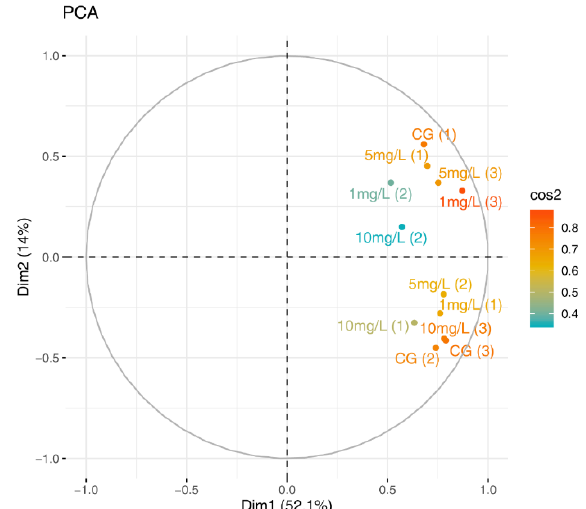
Figure 3. Nanoplastic (NP)-introduced aquatic PCA ordination showing the microbial community carbon source utilization patterns (CSUPs). CG represents the control group. The cos2 values are used to estimate the quality of the representation. The closer a variable is to the circle of correlations, the better its representation on the factor map and the more important it is for interpreting these